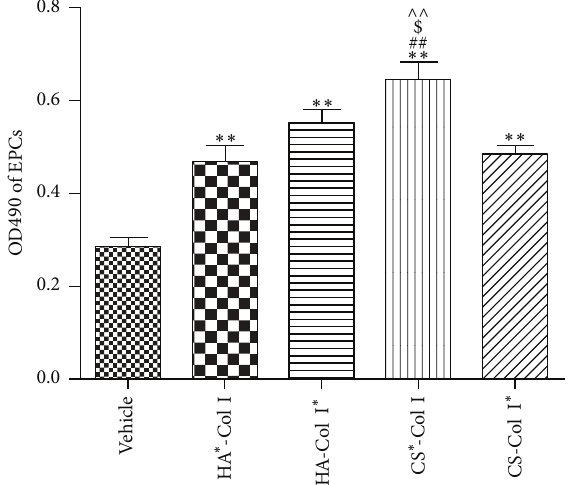
Figure 2: Effects of multilayer composite biomaterial membranes on the proliferation of EPCs. CS ∗ -Col I group showed the most significant effect on the EPC proliferation. ∗∗ 𝑝 < 0.01 versus vehicle, ## 𝑝 < 0.01 , $ 𝑝 < 0.05 , and ∧∧ 𝑝 < 0.01 versus HA ∗ -Col I, HA-Col I ∗ , or CS-Col I ∗ , 𝑛 = 3